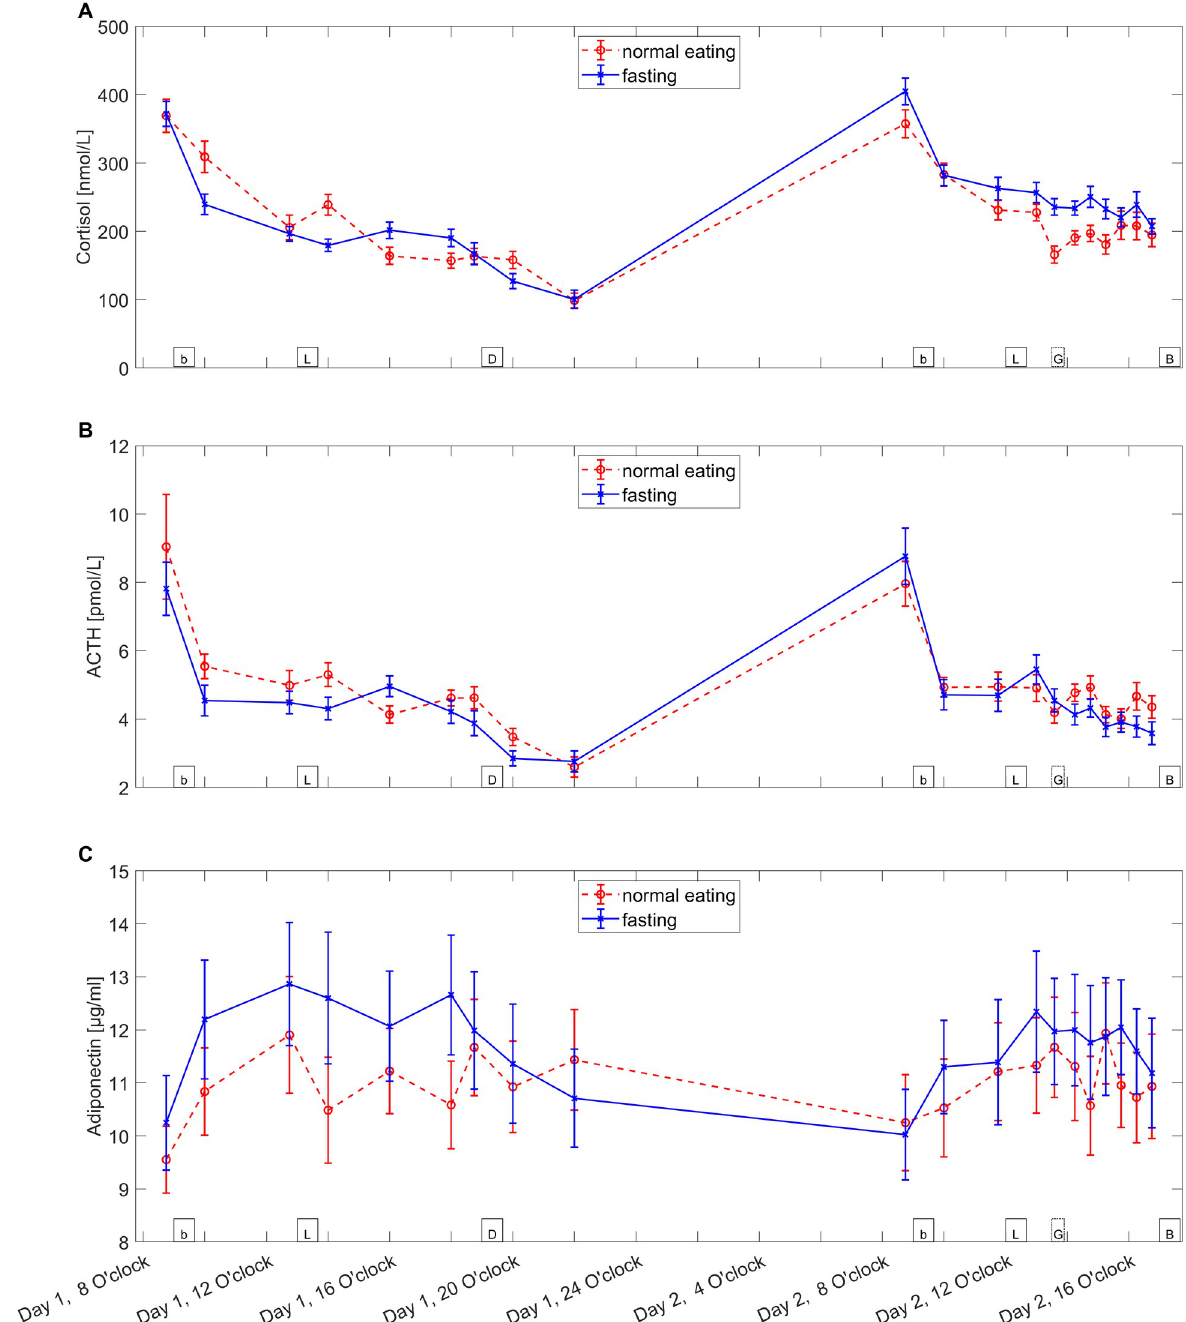
Fig 2. Levels of cortisol (A), ACTH (B) and adiponectin (C). The Figure shows the mean ± standard error of the mean for both fasting (blue line, crosses) and normal eating (red spotted line, circles) condition of the serum parameters during the experiment. Boxes on the bottom of the graph indicate the timepoints of meals (b = breakfast, L = lunch, D = Dinner, G = oral glucose administration, B = Buffet).